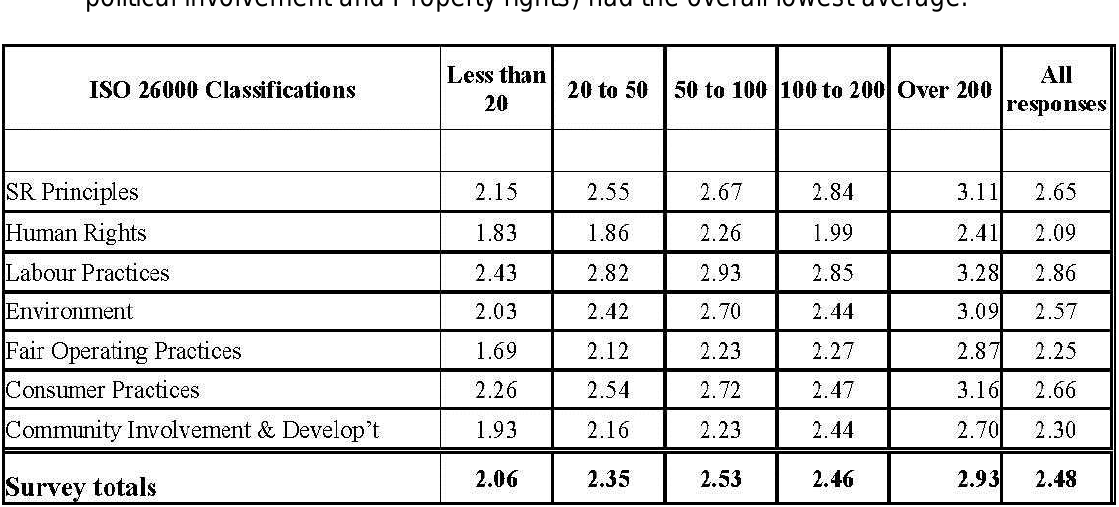
Table 7 CSR Grading (mean) by classification summary of